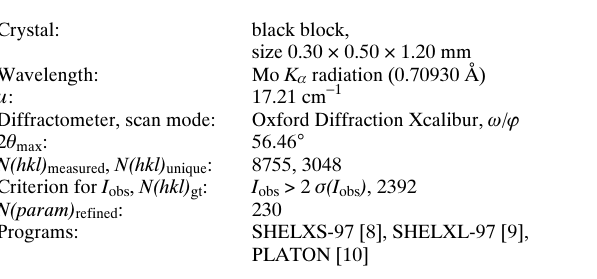
Table 1. Datacollection and